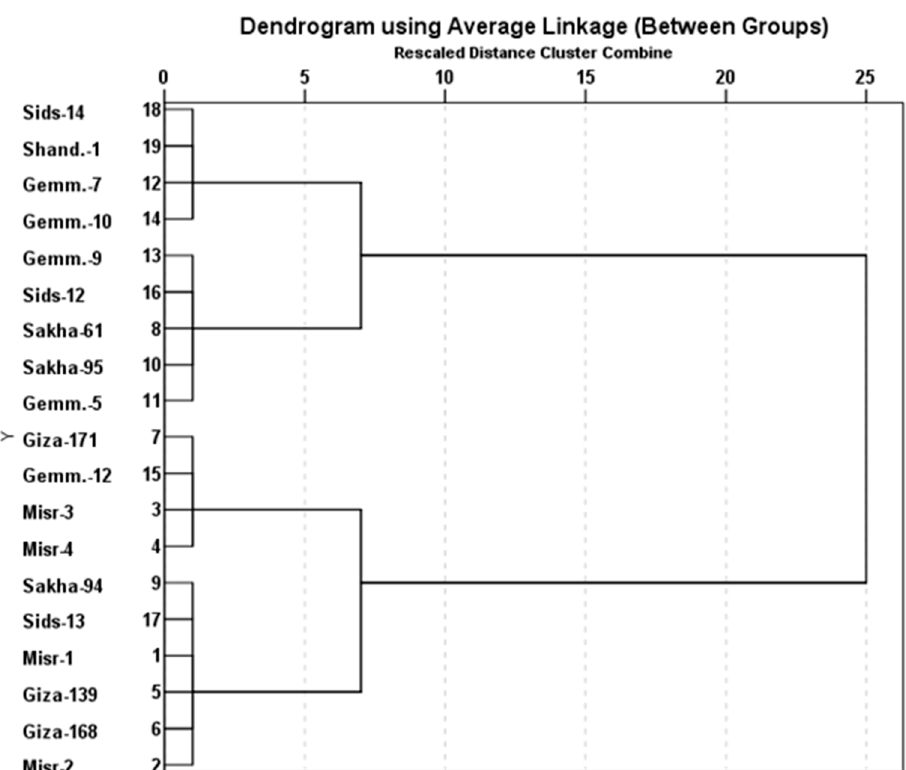
Figure 8. The polygenic tree of 19 wheat genotypes using the identified genes.